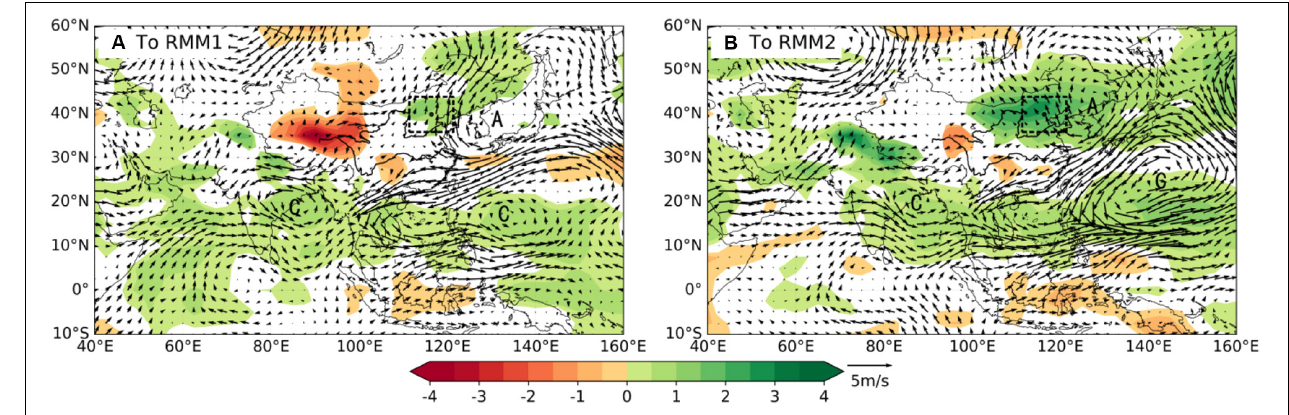
FIGURE 7 | The regressed pattern of anomalous wind at 850 hPa onto (A) RMM1 and (B) RMM2 in the summer of 2018 (arrowheads, unit: m · s - 1 ). The shaded areas are the convergence and divergence of water vapor (exceeds the 95% confidence level). Unit: g · kg - 1